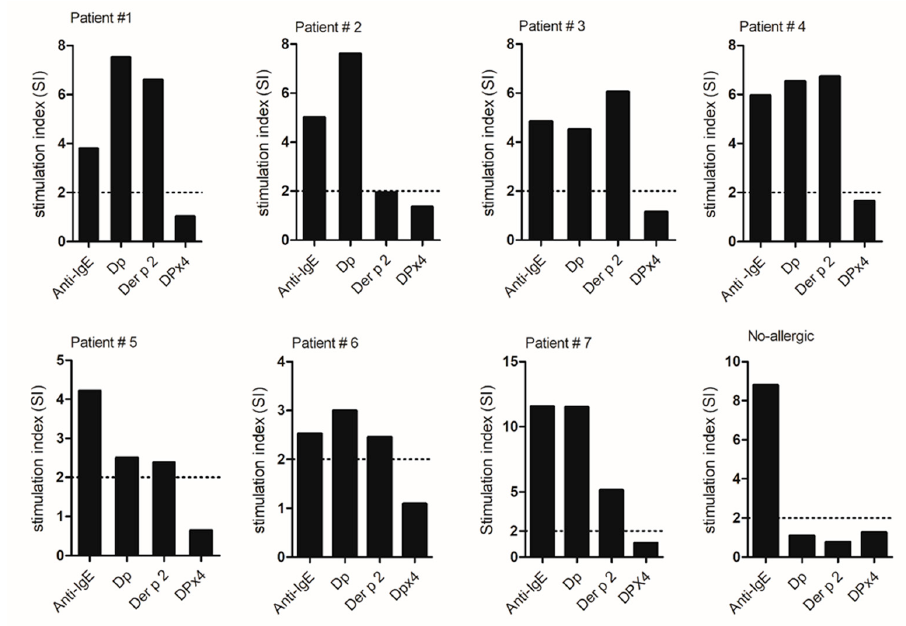
Figure 5. Basophil activation test. Stimulation index obtained in samples from seven allergic patients stimulated with anti-IgE, Dp (extract), Der p 2, and DPx4. 2.6. DPx4 Induced Higher Levels of IL-10 and Lower Levels of IL-5 than Mite Extract in Allergic Patient´s PBMCs